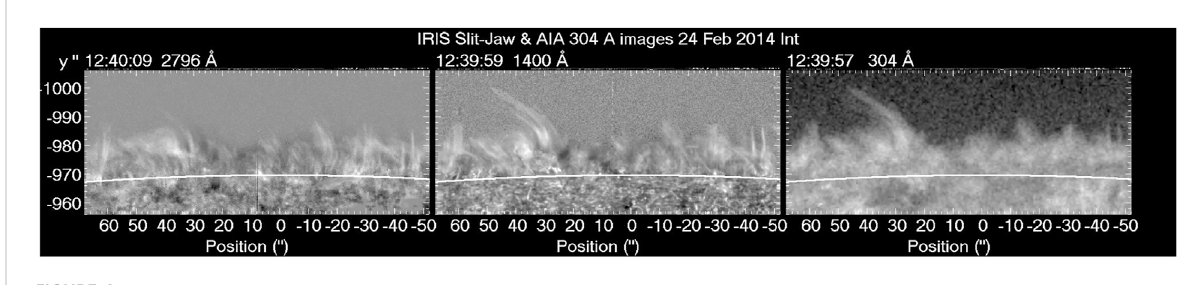
FIGURE 4 Spicules beyond the limb near the south pole of the sun, as seen in IRIS slit-jaw images with a bandwidth of 4 Å around the Mg II 2796 Å k line (left),andwithaspectralwidthof55 Åinthe1400 ÅbandwhichincludestheSi IV lines(center),aswellasinanAIAimageintheHe I _ I 304 Åline(right). Time-averagedimageshavebeensubtractedfromtheoriginalIRISdataforbettervisibilityofspicules.Thewhitearcmarksthesolarlimb.Solarsouth is up. The spatial resolution of IRIS ia about 4 times better than that of AIA. Figure made by the authors from IRIS and AIA